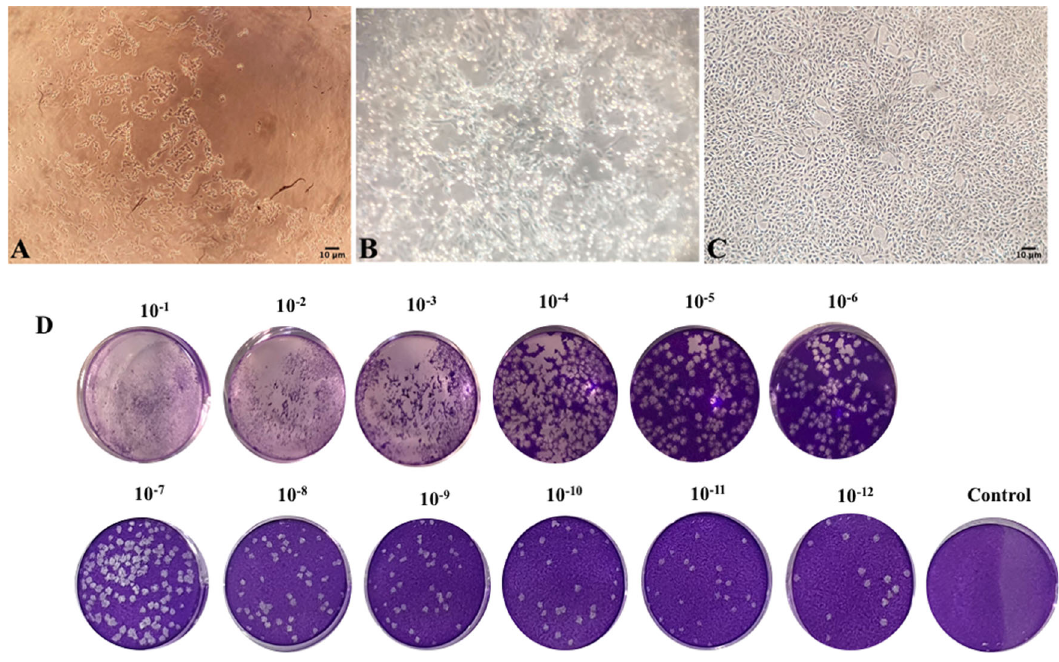
Figure 1. (A) Cytopathic effect of infected Vero E6 cell in third blind passage on the eighth day post passage (40 (cid:1) magnification); (B) Cytopathic effect of infected Vero E6 cell in 15th blind passage on second day post passage (40 (cid:1) magnification); (C) Uninfected Vero E6 cell in 40 (cid:1) magnification; (D) Plaque-Forming Unit (PFU) evaluation (Nikon TMS inverted microscope,